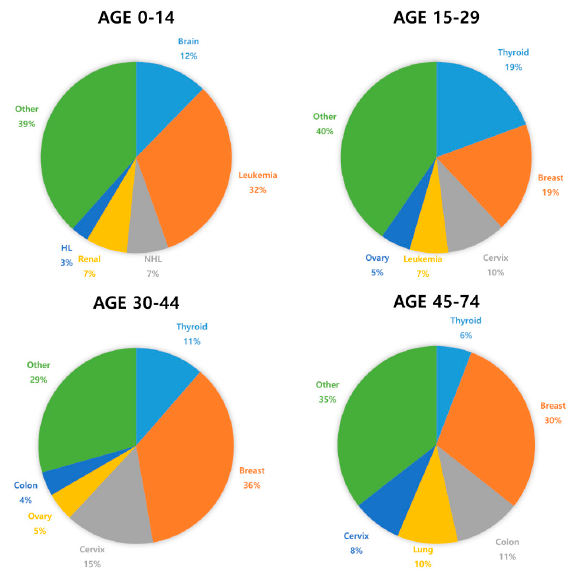
Figure 1. The most commonly diagnosed cancer types in females by age worldwide (2018) [27]. Table 1. Common malignancies occurring in prepubertal girls and women at reproductive age and the risk of chemotherapy-induced gonadotoxicity.